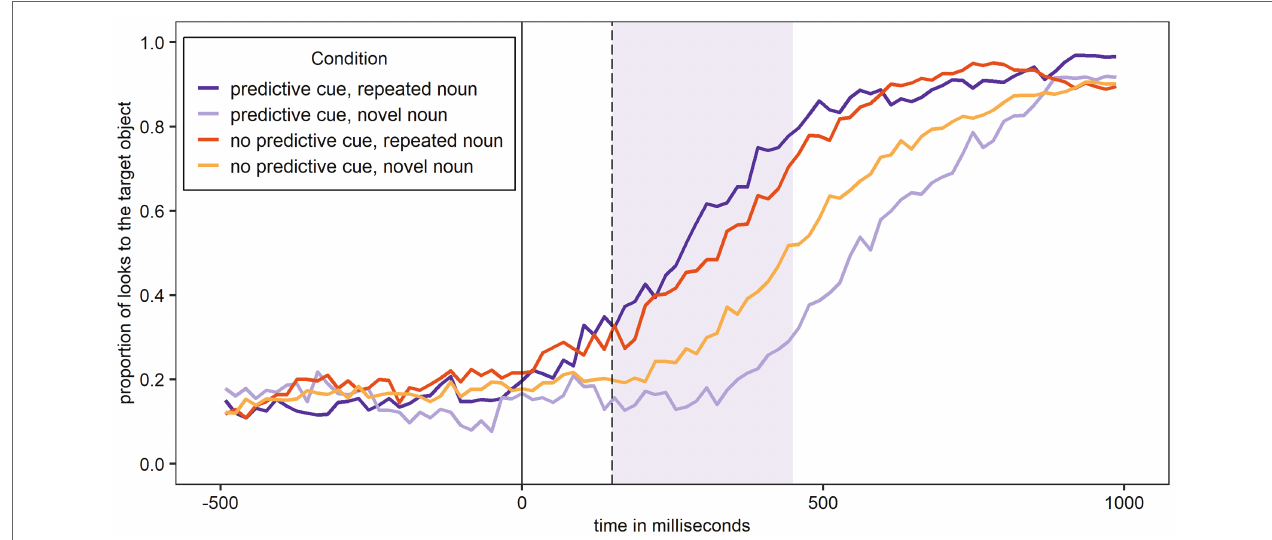
FIGURE 4 | Proportion of looks over time to the target object across conditions in English (L2). The shaded area corresponds to the analysis window.